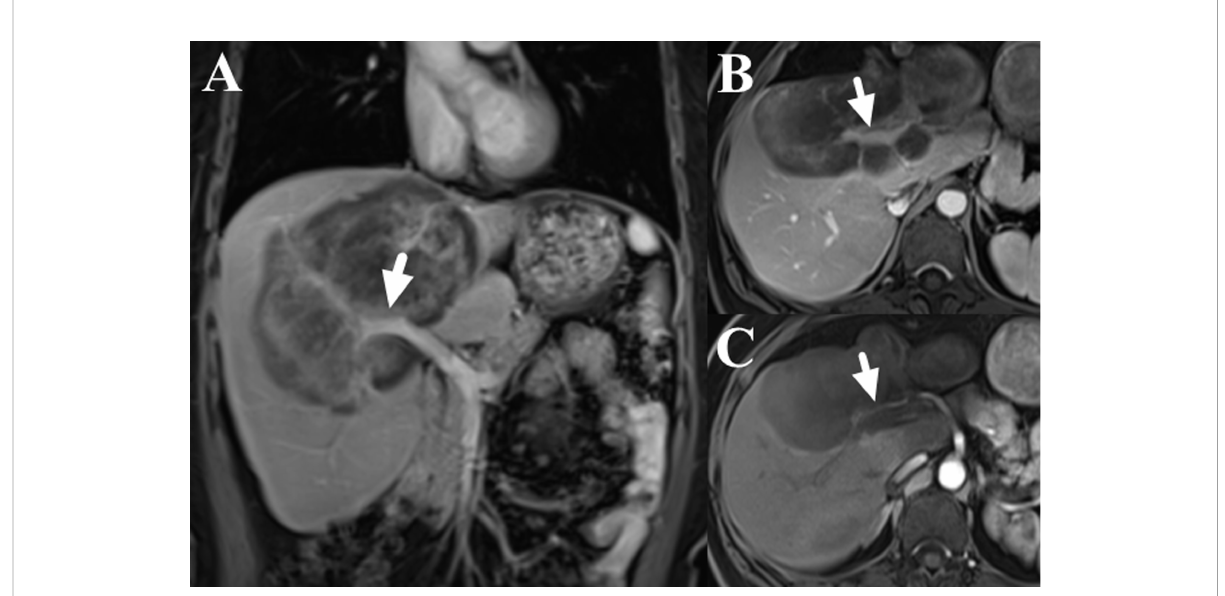
FIGURE 2 Contrast-enhance images of liver MRI (dose: 0.1 mmol/kg; injection rate: 2.0 ml/s; TR/TE: 3.6/1.7 ms; slice thickness: 5 mm; image matrix: 256 × 192; fi eld of view: 40 × 44 cm; the scanning delay times were 20s, 60s and 180s for the arterial, portal and delay phases, respectively), which showed the involvement of right branch of portal vein ( A, B, marked with arrows) and right hepatic artery ( C, marked with arrow).